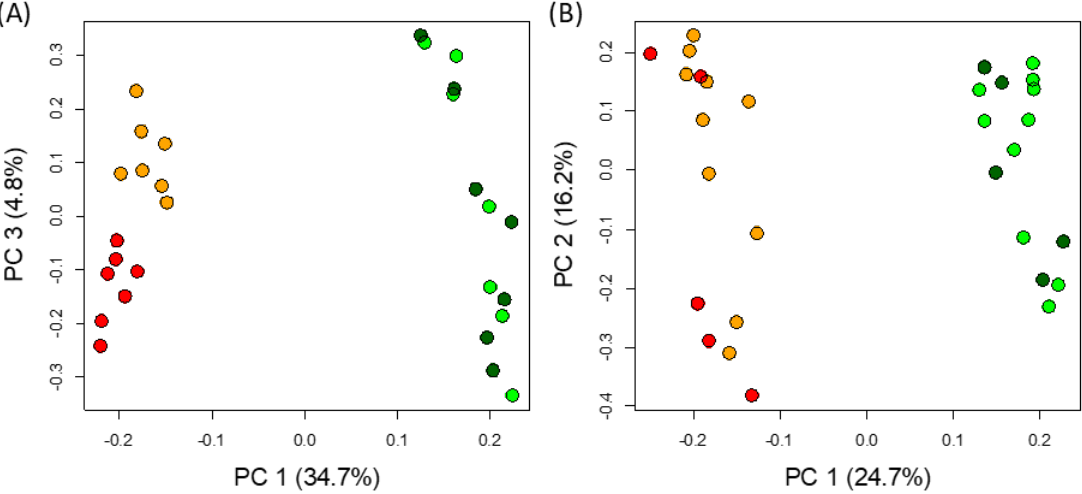
Figure 3. Unsupervised analysis of all detected features. PCA analysis of features detected in polar ( A ) and non-polar ( B ) extracts. Tissue and feeding status are indicated by the colors dark green and light green, showing fed and not-fed leaves, and red and orange, showing fed and not-fed pitchers, respectively.